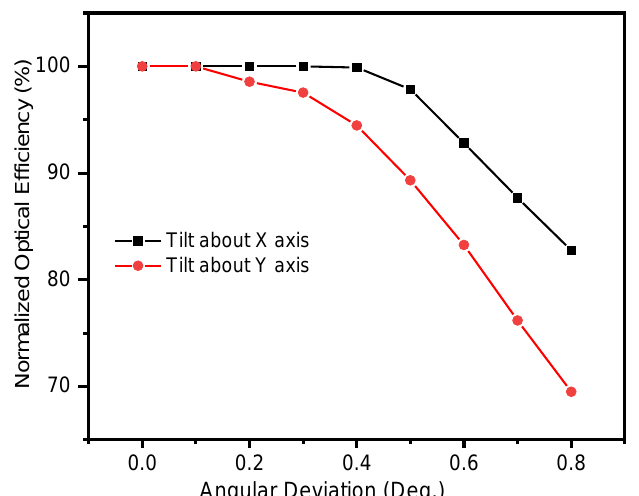
Figure 15. Normalized optical efficiencies of our proposed HCPV system under various incidence angles along x -axis and y -axis.